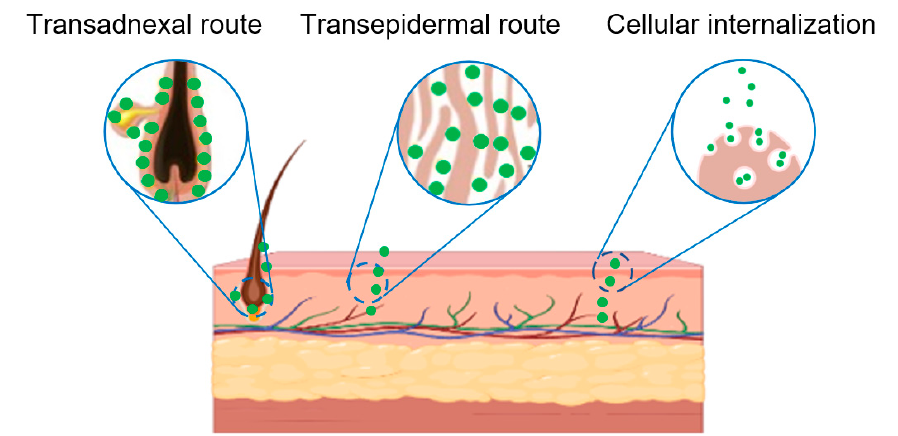
Figure 4. Schematic diagram of the transdermal administration of PELNV.